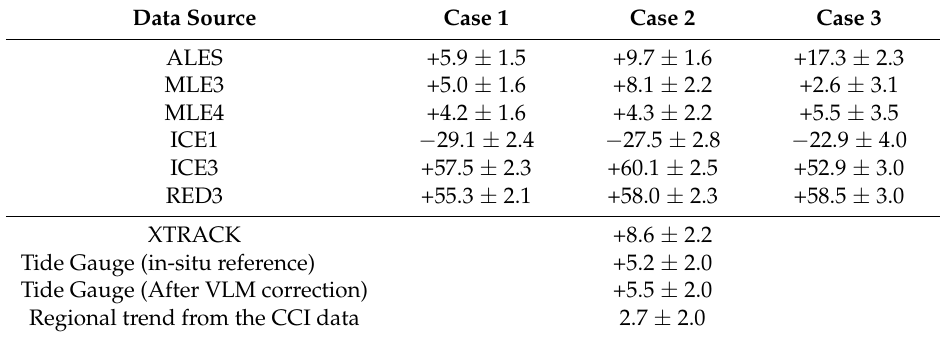
Table 3. Estimated linear trend and associated uncertainty (mm/yr) as a function of sea level data source and